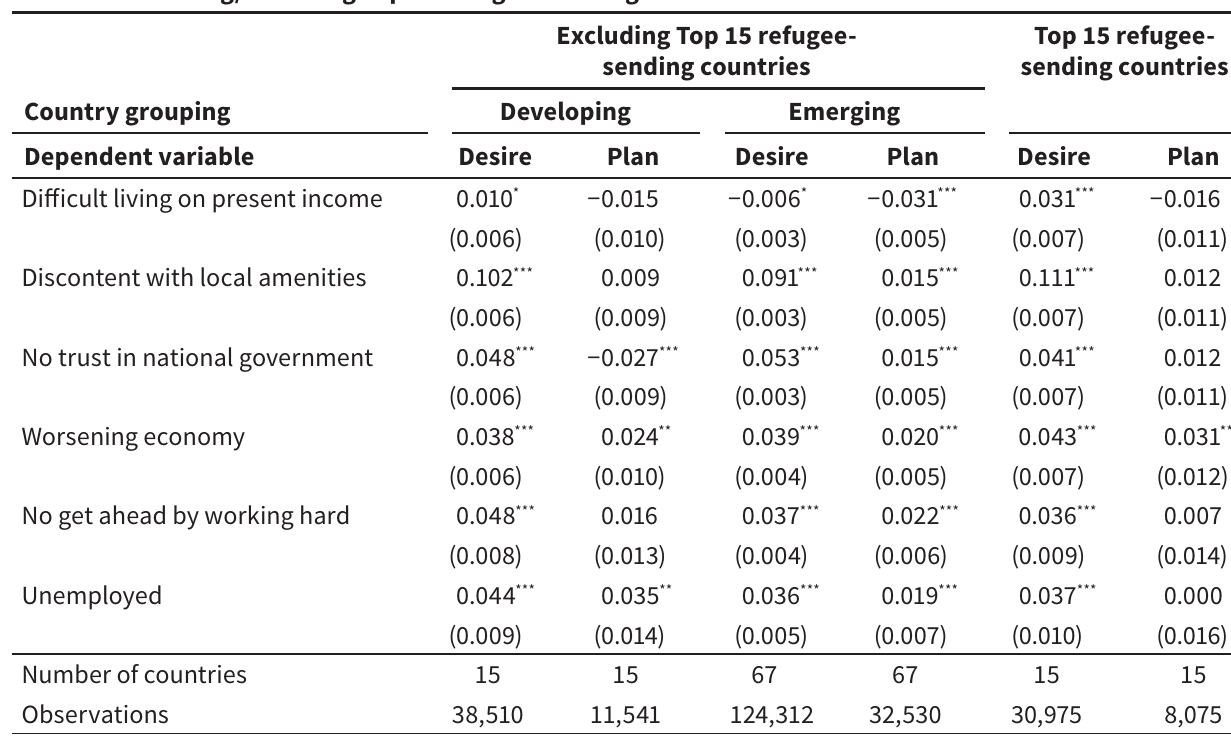
Panel C: Including/excluding Top 15 refugee − sending countries